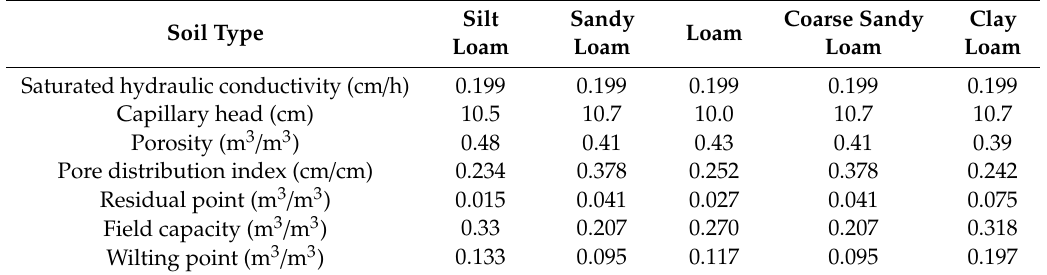
Table 1. Soil infiltration parameter values from soil textural classification [36].